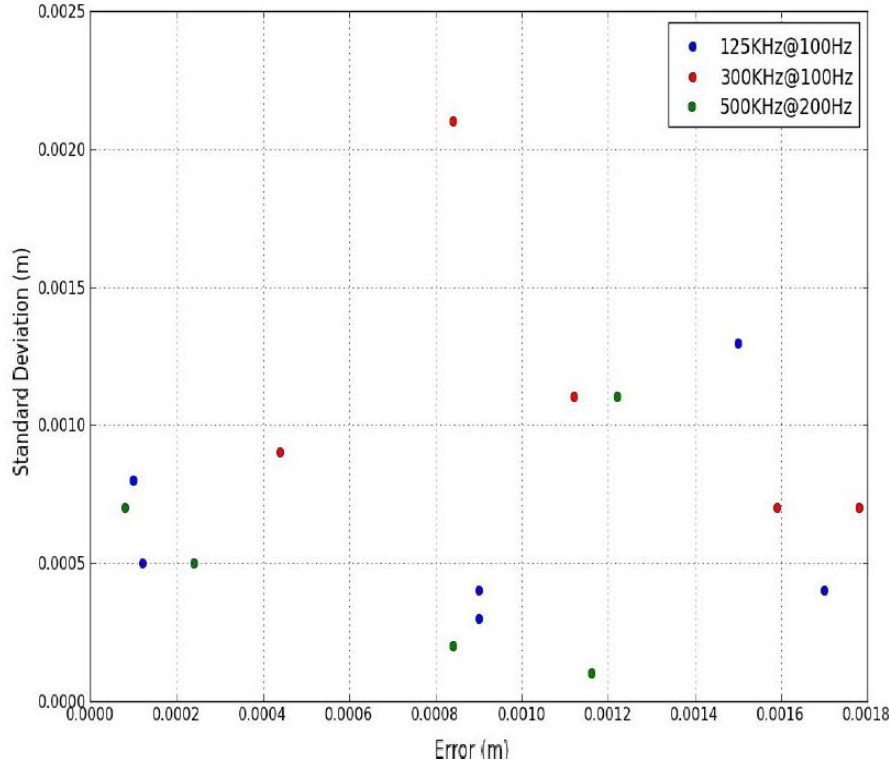
Figure 8. MIMIC’s point spacing calculations: Calculating average error over five point spacing measurements plotted against measurement reliablity ( σ) for three PRRs and two M